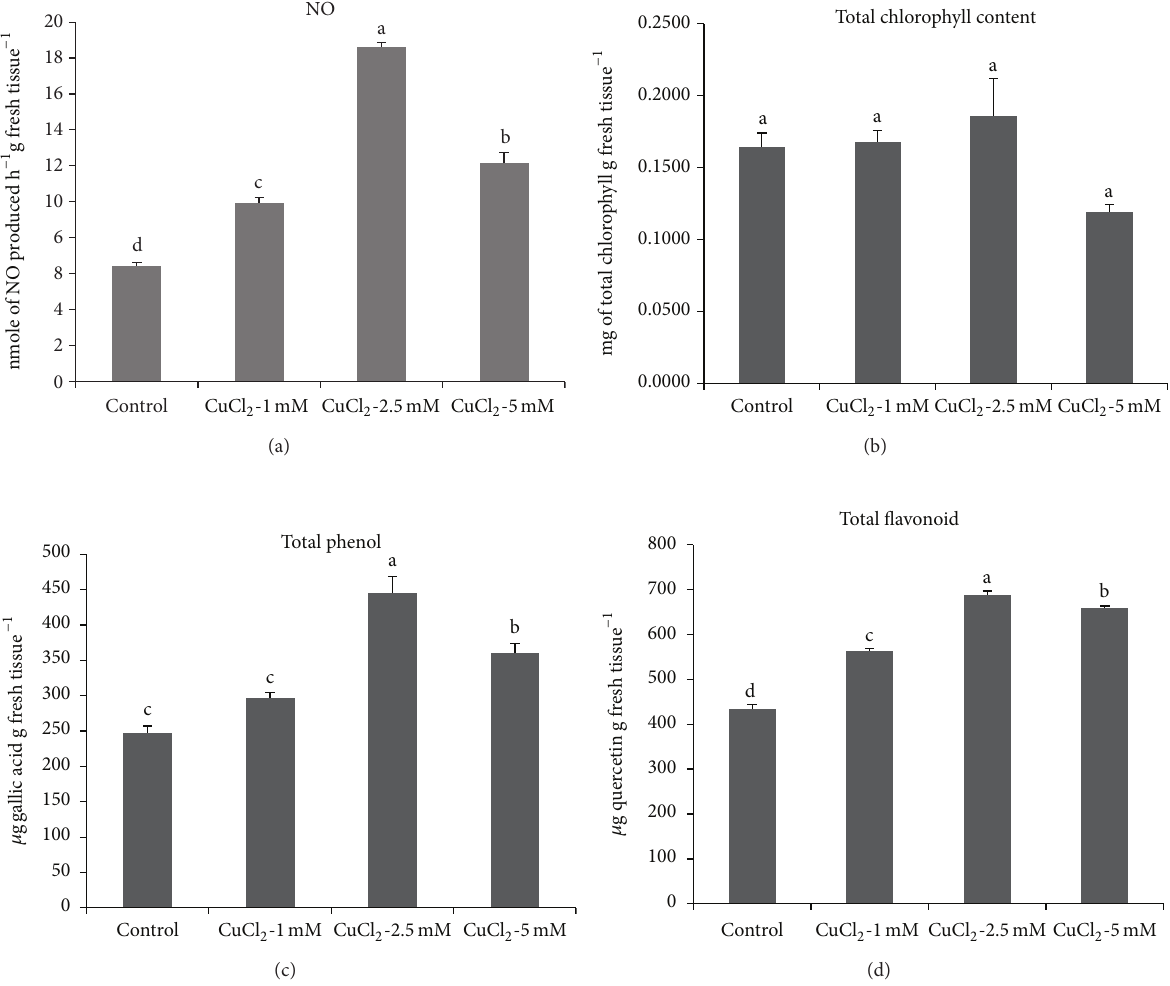
Figure 1: Effect of CuCl 2 on production of NO (a). Total chlorophyll (b), Total phenol (c), and Total flavonoid content (d), in tomato plants. Values represent mean ± SE of three separate experiments, each in triplicate. Sharing the same letter are not significantly different ( 𝑃 < 0.05 ) using Duncan’s multiple range